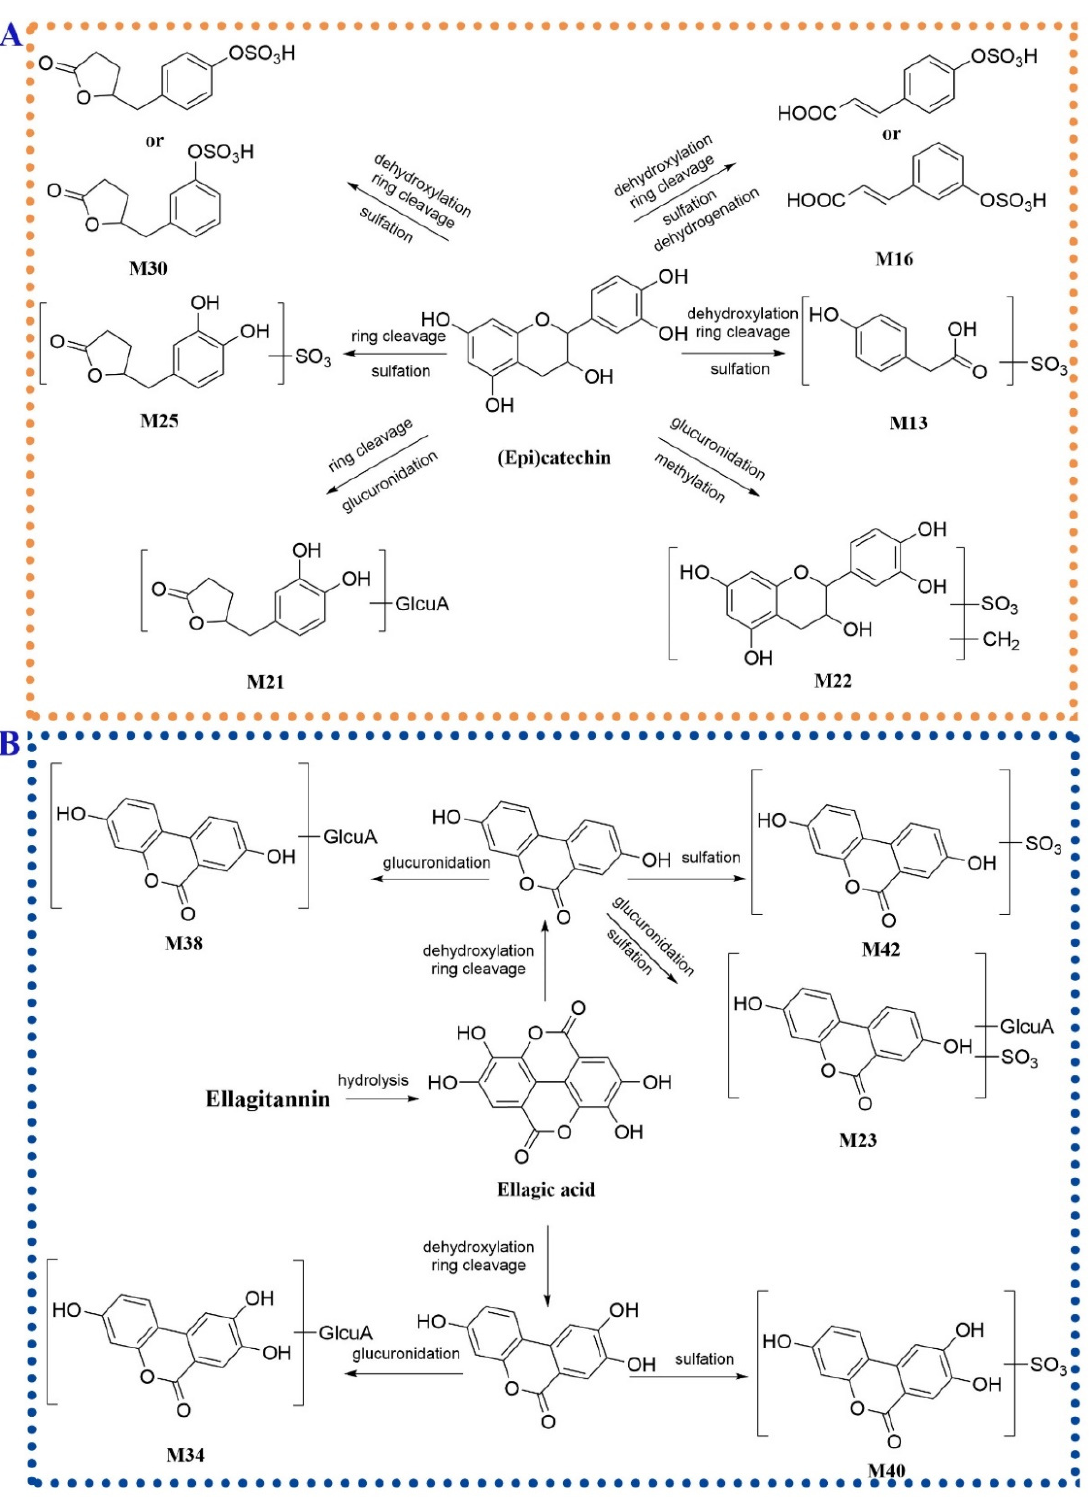
Figure 6. The possible metabolic pathways of (epi)catechin ( A ) and ellagitannins ( B ) in hyperuricemia rats administered orally with P. capitatum extract.